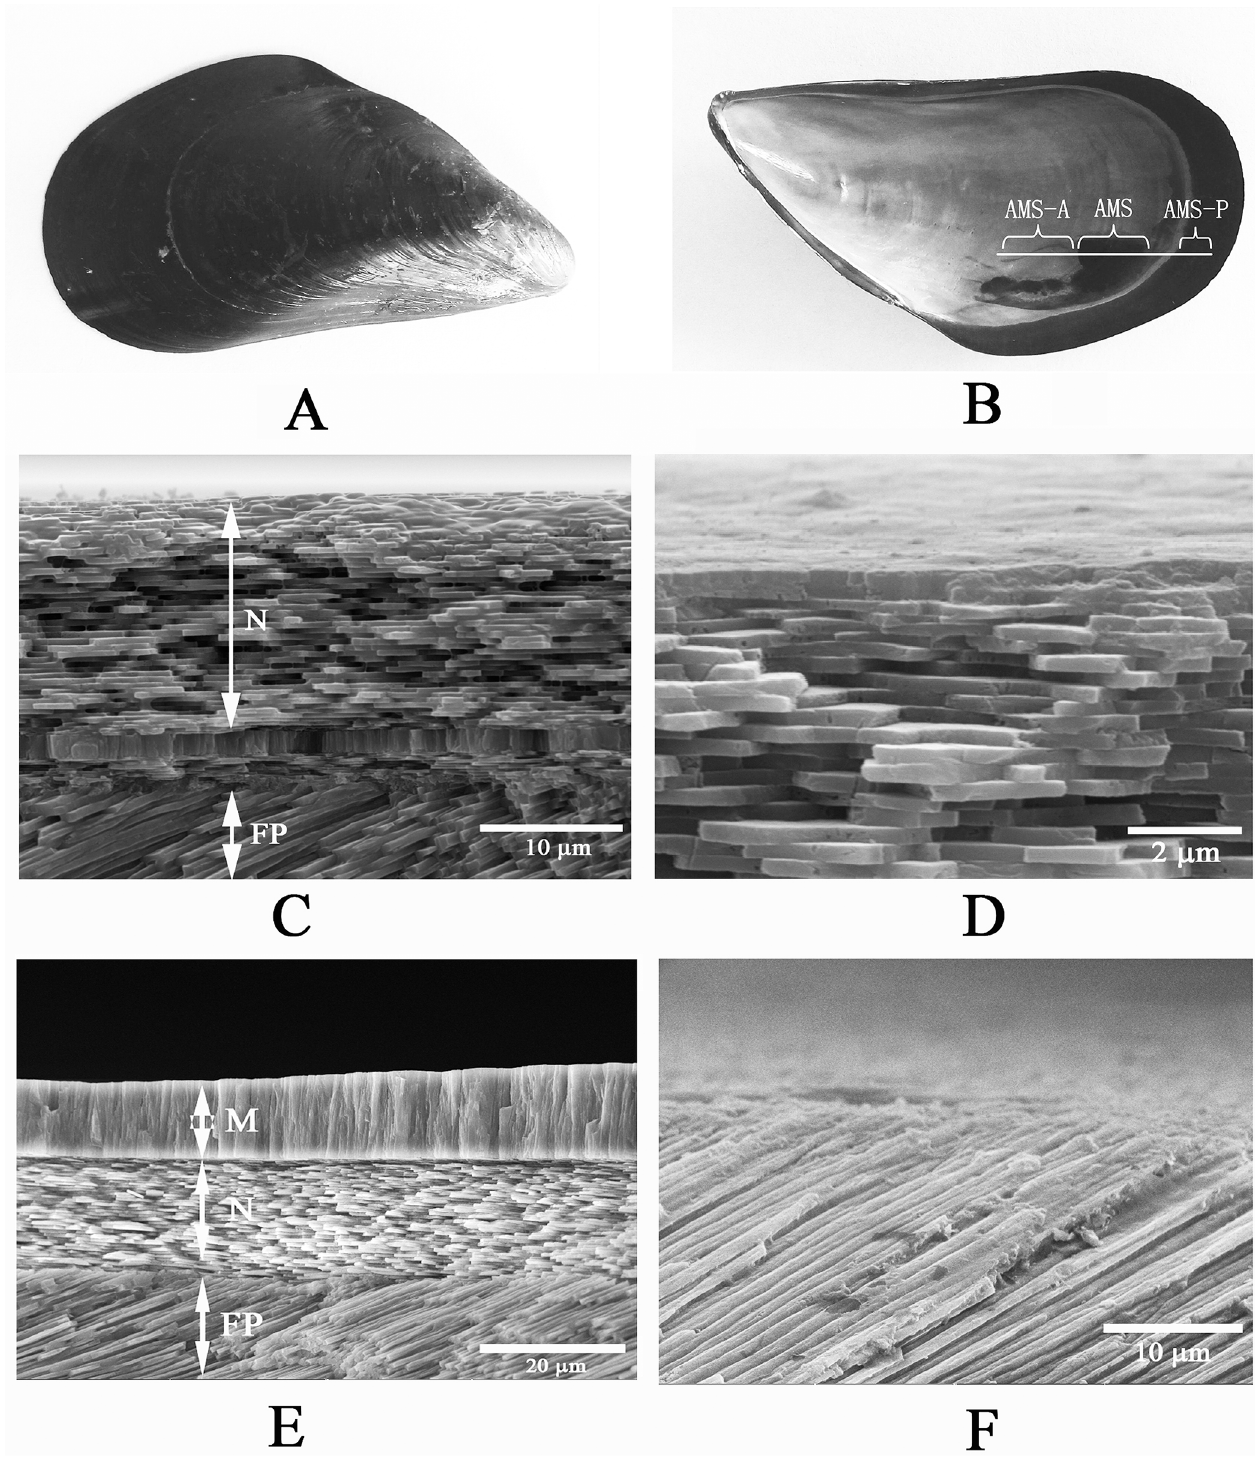
Fig 1. The photograph of the whole shell and the SEM images of cross-section of M . galloprovincialis shell. A: the exterior side of M . galloprovincialis shell; B: the interior side of M . galloprovincialis shell, the white line represents the cutting plane; “ AMS ” , “ AMS-A ” , and “ AMS-P ” represent the area of adductor muscle scar (AMS), anterior side of AMS, and posterior side of AMS, respectively. C: the cross-sectional SEM image of AMS-A, showed nacre (N) on the top layer and fibrous prism (FP) at the bottom of this area; D: enlarged image of nacre from AMS-A; E: the cross-sectional SEM image of central AMS, showed myostracum (M) at the top, nacre (N) at the middle, and fibrous prism (FP) at the bottom of this area; F: the cross-sectional SEM image of AMS-P, showed fibrous prism at this area. doi:10.1371/journal.pone.0133913.g001 PLOS ONE | DOI:10.1371/journal.pone.0133913 July 28,